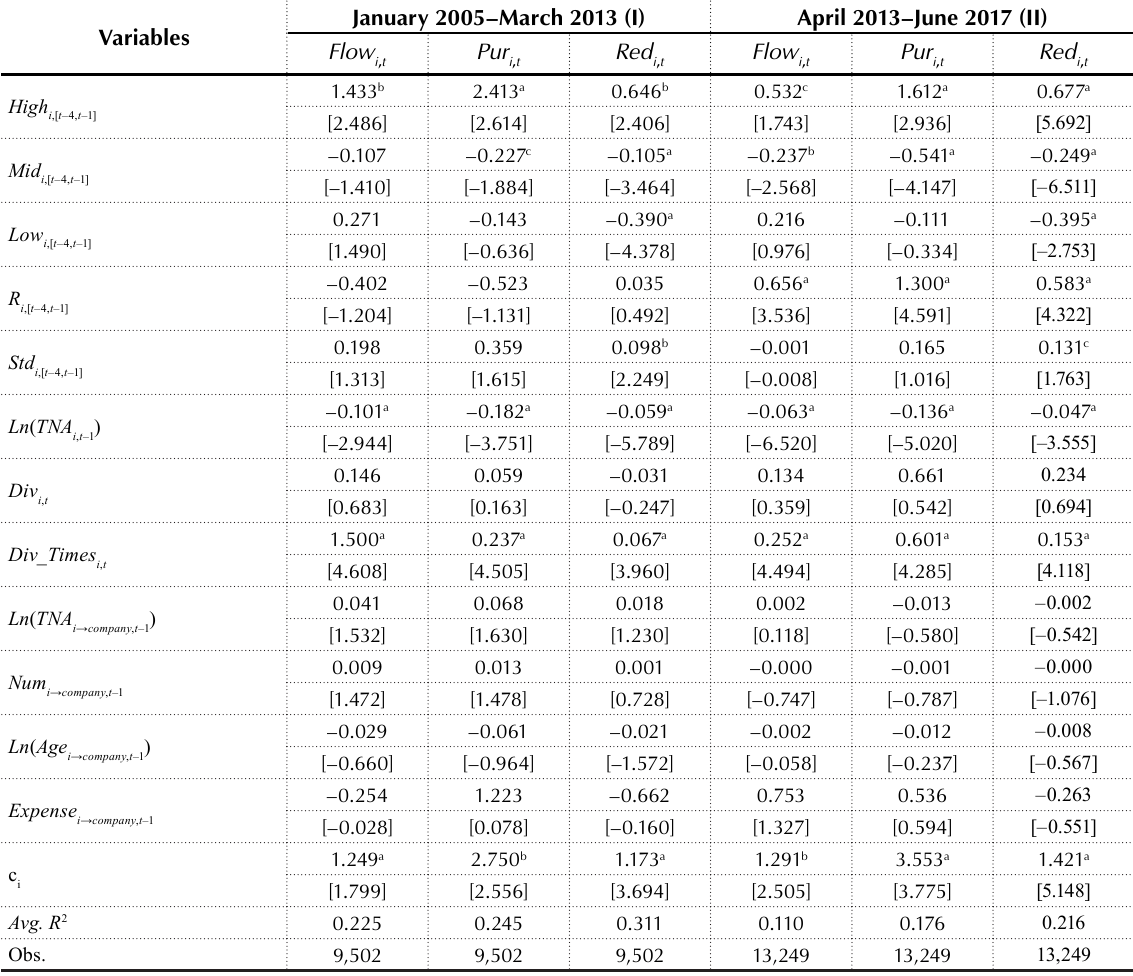
Table 4. Two subperiods: pre- and post-reform periods